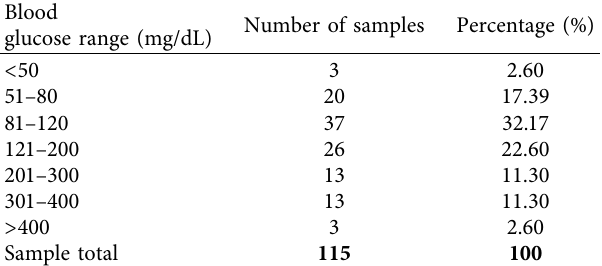
Table 1: Blood glucose ranges in dogs from